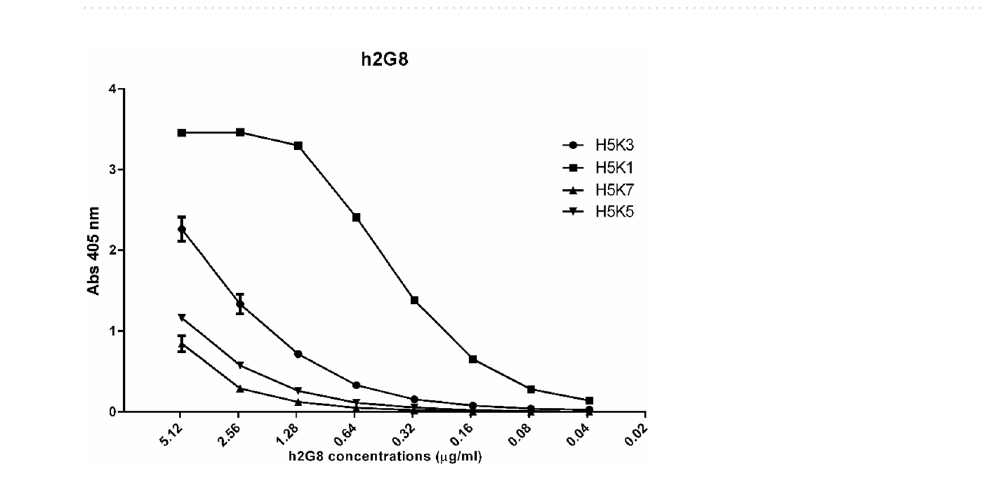
Table 1. Identifiers of the heavy and light chains selected for further experimental inquiry, according to the protocol described in the text. The identifier names are related to our internal naming scheme.